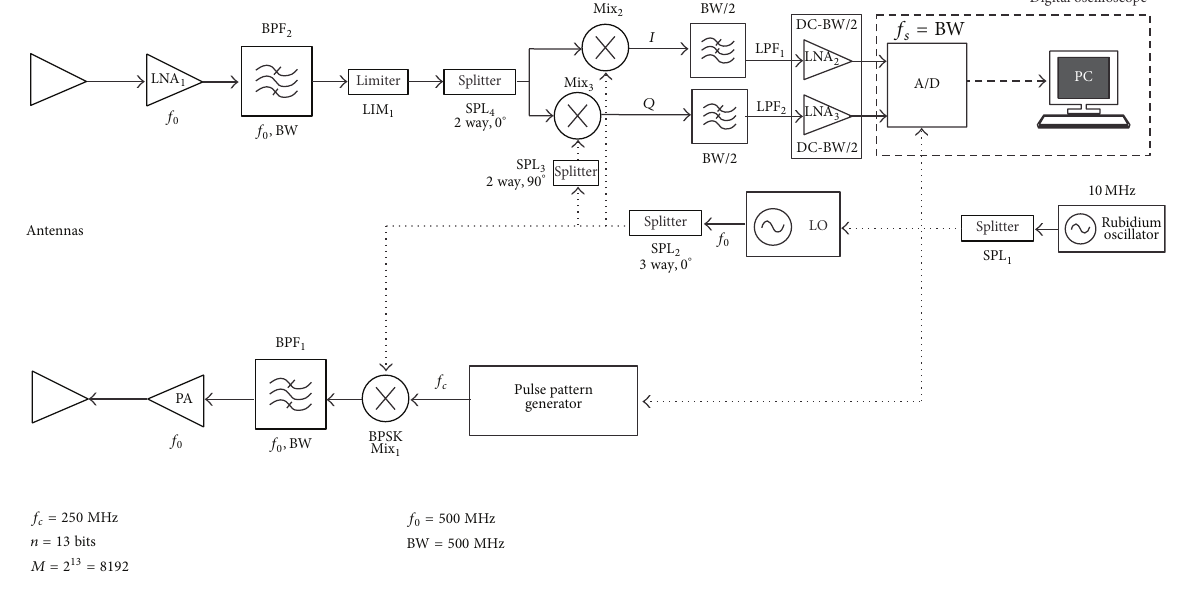
Figure 5: System block diagram.